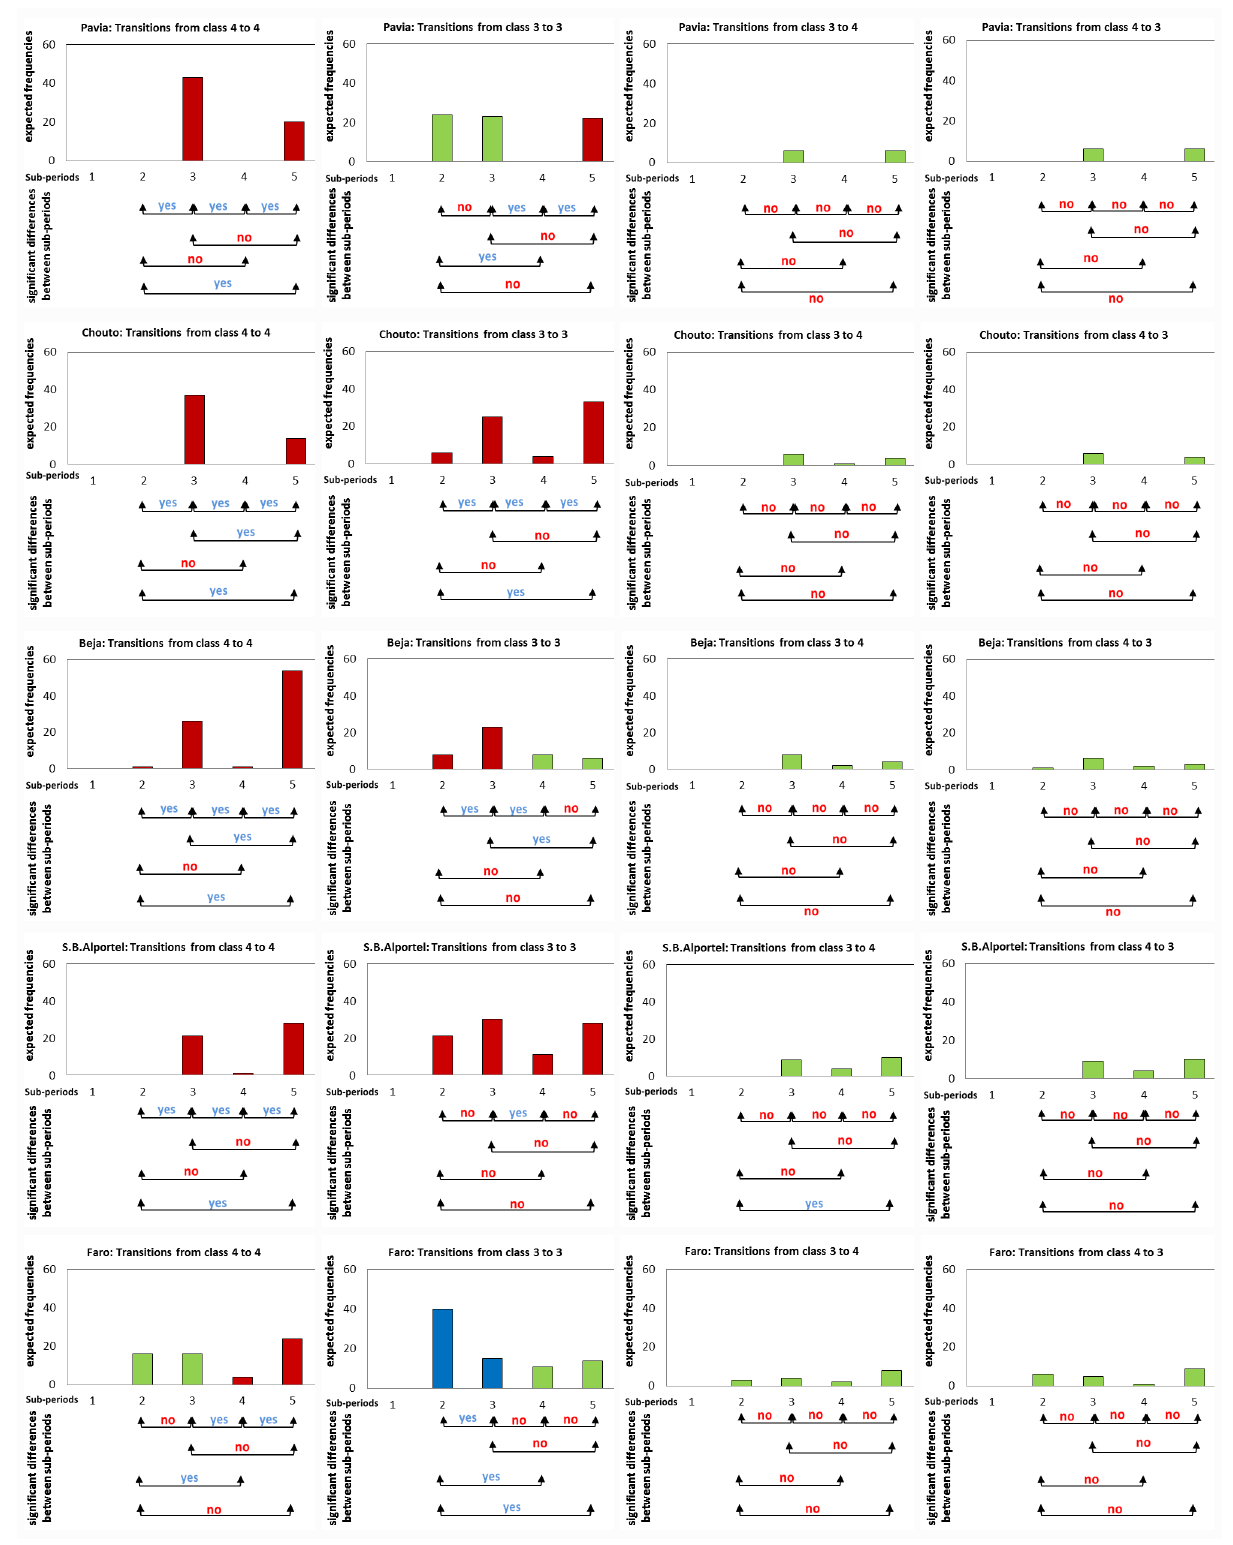
Fig. 6. Number of transitions between drought classes by sub-period and results for the Scheff´e multiple comparison of sub-periods. Arrows point to pairs of sub-periods being compared: “yes” when their differences are significant, “no”